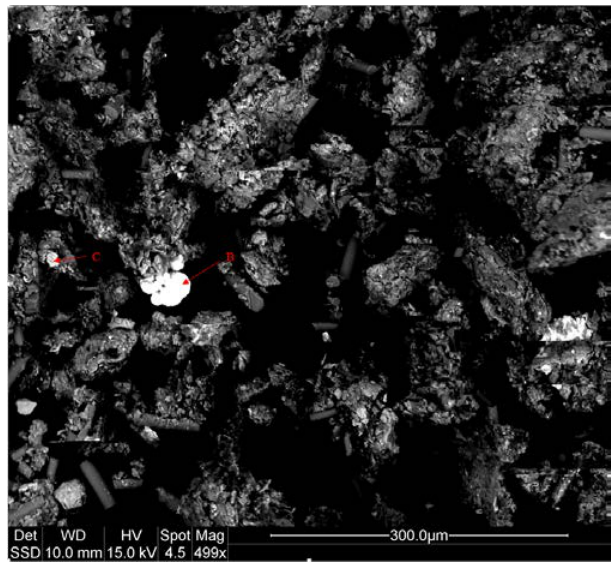
Figure 11. Backscattered Electron ( BSE) image of leaching residues.